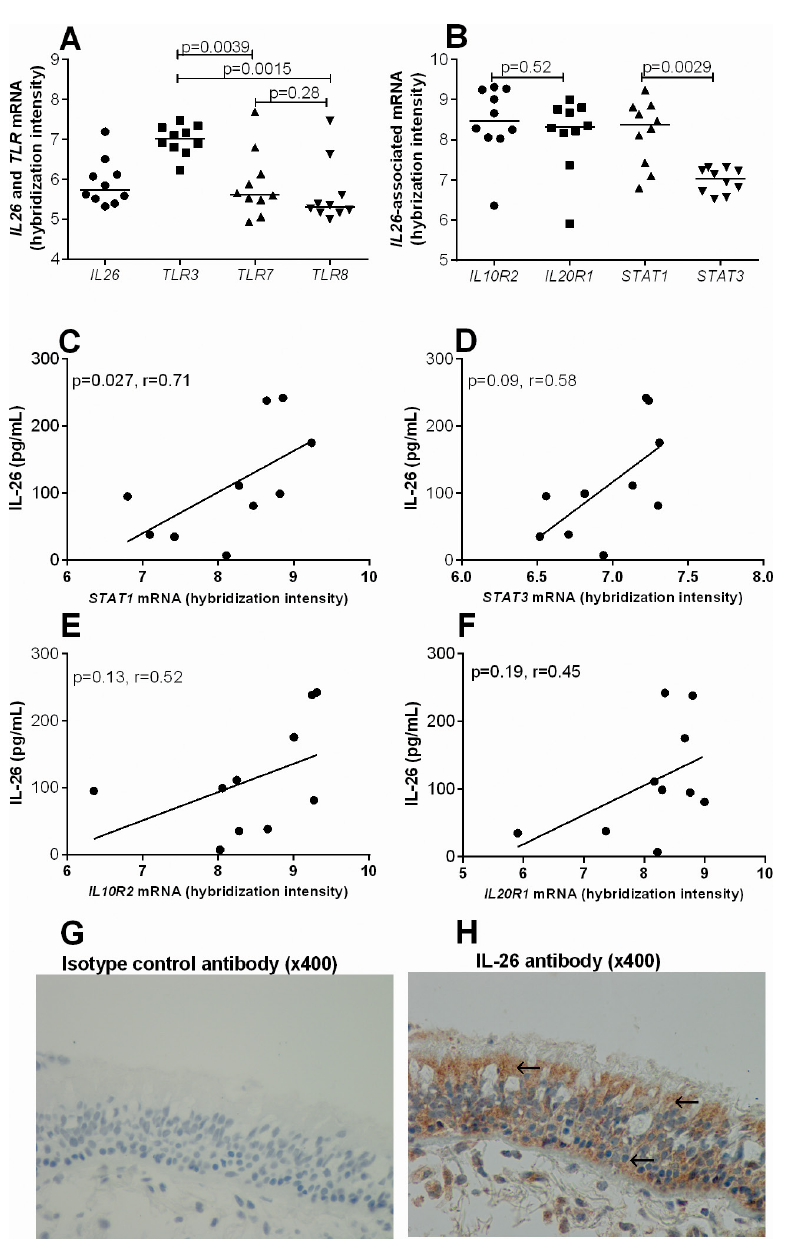
Figure 6. IL-26 in bronchial brush biopsies and bronchial tissue biopsies. The gene expression profile of epithelial cells in bronchial brush biopsies was determined by mRNA analyses. (A) IL26 and TLR3 , TLR7 and TLR8 mRNA levels (n = 10). (B) The mRNA level for the IL-26 associated genes IL26 , IL10R2 , IL20R1 , STAT1 and STAT3 (n = 10). (C–F) Correlation between BAL IL-26 protein (67pg/mL [7–238pg/mL]) and mRNA levels for STAT1 , STAT3 , IL10R2 and IL20R1 respectively (n = 10). Cellular IL-26 protein expression in bronchial tis- sue biopsies was determined using IHC. (G) Monoclonal IgG2b isotype control antibody and (H) positive staining (brown) with monoclonal specific IL-26 antibody. Arrows show granular and cytoplasmic IL-26 expression. Each panel show a representative staining out of 8 subjects at a magnification of 400×. The p values indicated are according to the Mann–Whitney test (A and B) and Spearman correlation test (C–F) and p < 0.05 is consid- ered